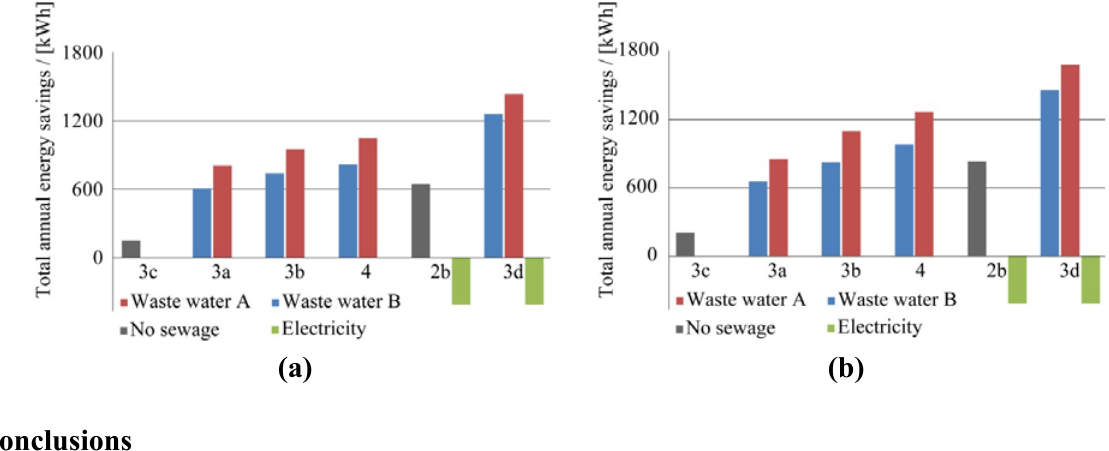
Figure 5. The saving potential for the different systems for waste water flow Profiles A and B, see Figure 2, ( a ) are the results for the low energy building; and ( b ) are the results for the standard insulated